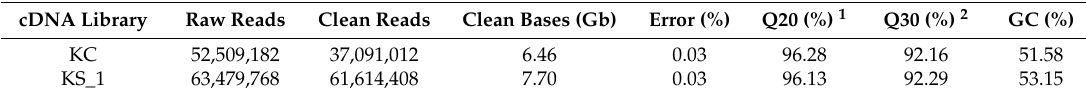
Table 1. Summary of the RNA-Seq data.